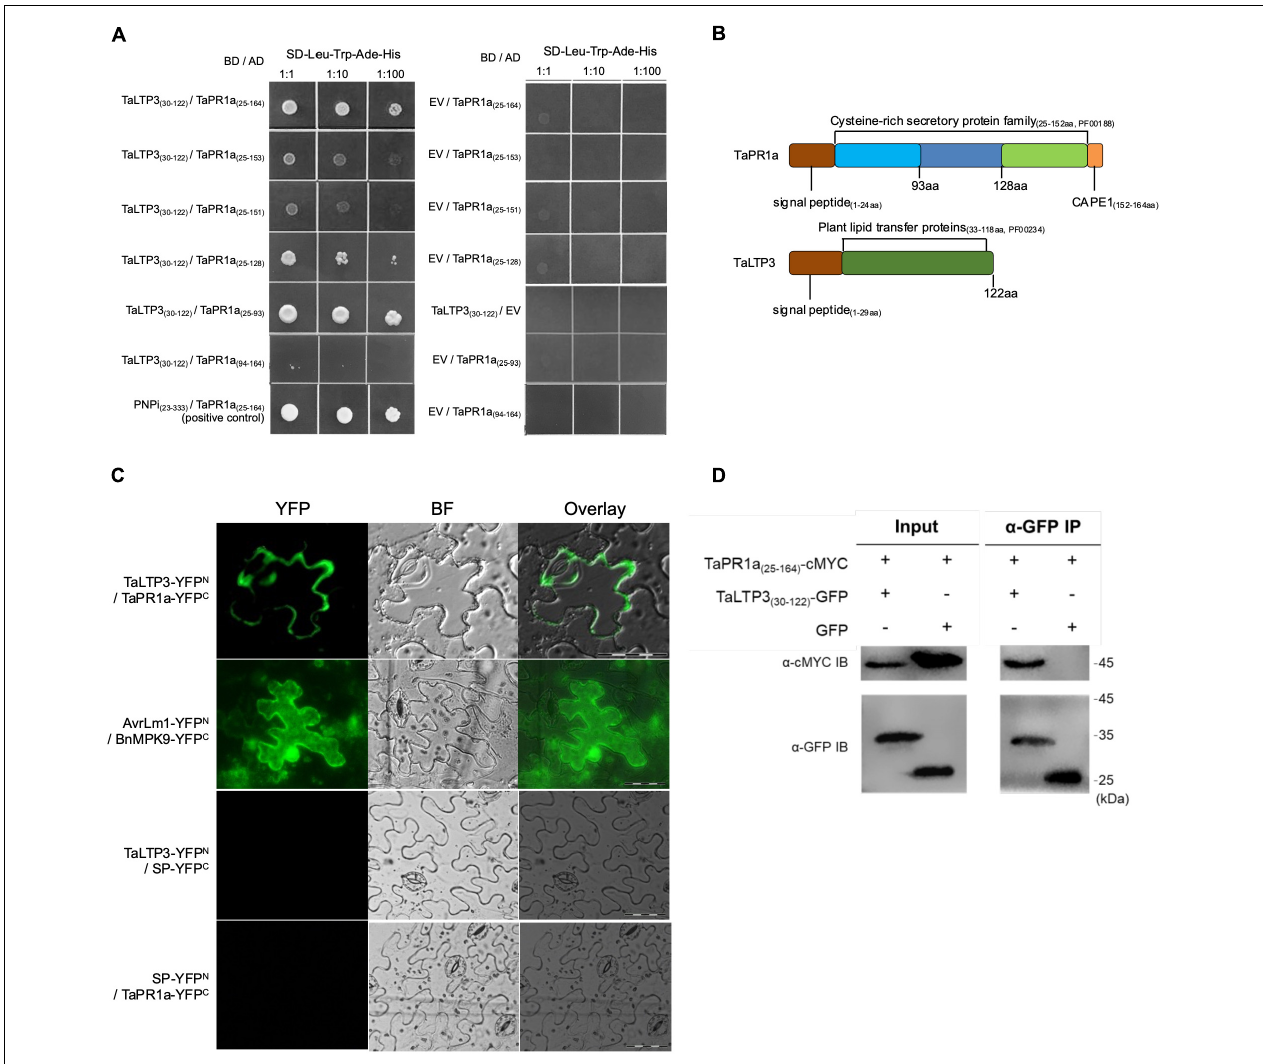
FIGURE 5 | TaLTP3 physically associated with TaPR1a in vitro and in vivo . (A) Interaction of TaLTP3 and TaPR1a was detected by Y2H. Yeast transformants coexpressing different bait and prey recombinant constructs were tested on selective medium of SD-Leu-Trp-His-Ade, EV, and empty vector. (B) Signal peptide and conserved domain for TaPR1a and TaLTP3 proteins were schematically presented. (C) Bimolecular fluorescence complementation (BiFC) assay showed that the interaction between TaPR1a and TaLTP3 occurred in the apoplastic space. YFP signals were observed in the tobacco leaves coexpressing TaLTP3-YFP N and TaPR1a-YFP C . Recombinant constructs of AvrLm1-YFP N and BnMPK9-YFP C were coexpressed as a positive control. Segment encoding signal peptide of TaPR1a was cloned into BiFC vectors as SP-YFP N and SP-YFP C as negative controls. Scale bar = 100 µ m. Due to the fixed microscopy settings for visualizing yellow and green fluorescent signals, the yellow fluorescent signals were presented in green color. (D) Validation of the interaction between TaPR1a and TaLTP3 by co-immunoprecipitation (Co-IP) assay. Total proteins from tobacco leaves transiently expressing TaPR1a ( 25 − 164 ) -cMYC and TaLTP3 ( 30 − 122 ) -GFP were extracted and immunoprecipitated with an α -GFP antibody ( α -GFP IP). Input and bound proteins were immunoblotted with α -GFP and α -cMYC antibodies, respectively. Original, uncropped blots for the Co-IP assay were displayed as Supplementary Figure 4 . BF, bright field; EV, empty vector; YFP, yellow fluorescent protein;